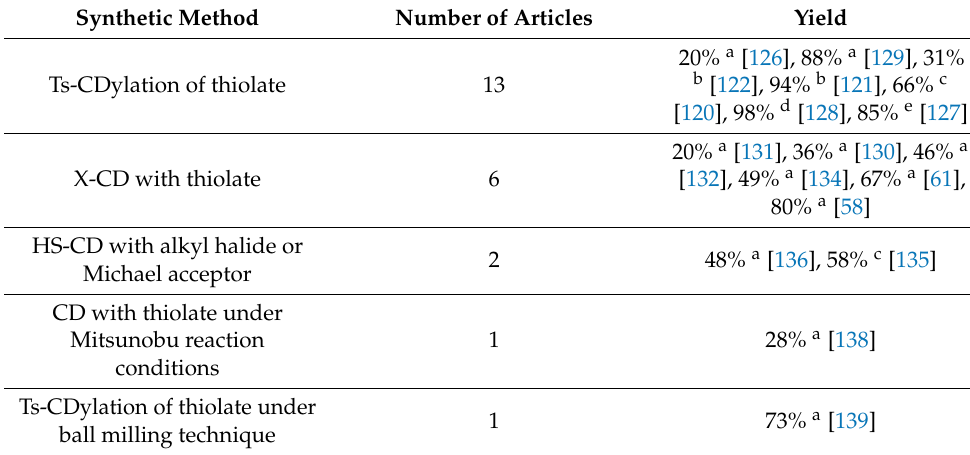
Table 5. Preparation of 6 A - S -aryls/alkyls/acyls of CDs. Synthetic Method Number of Articles